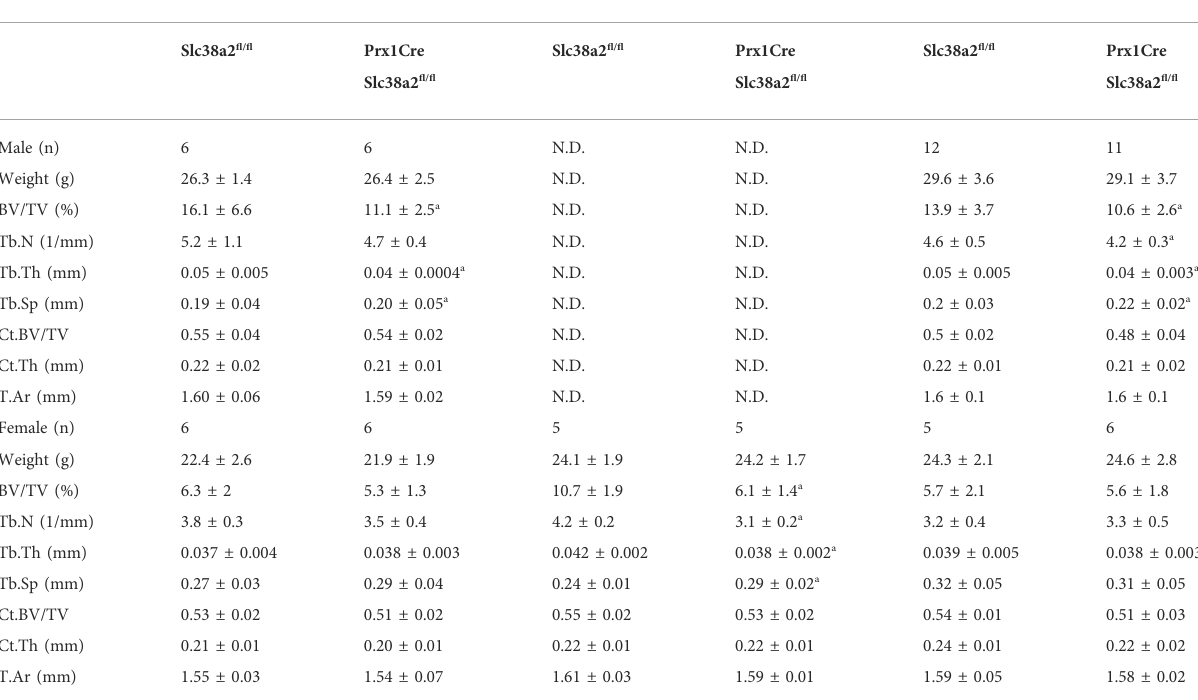
TABLE 2 Bone Parameters in Prrx1Cre;Slc38a2 fl / fl